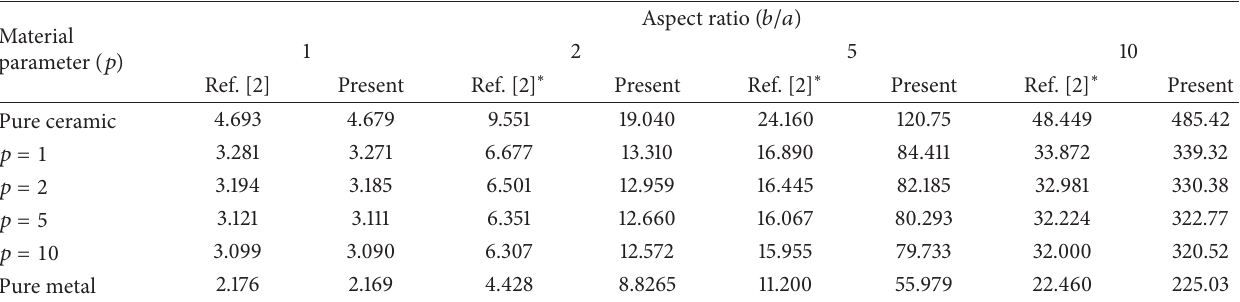
= (𝑁 𝑏 2 /𝐸 ℎ 3 ) × 10) . 2 cr cr